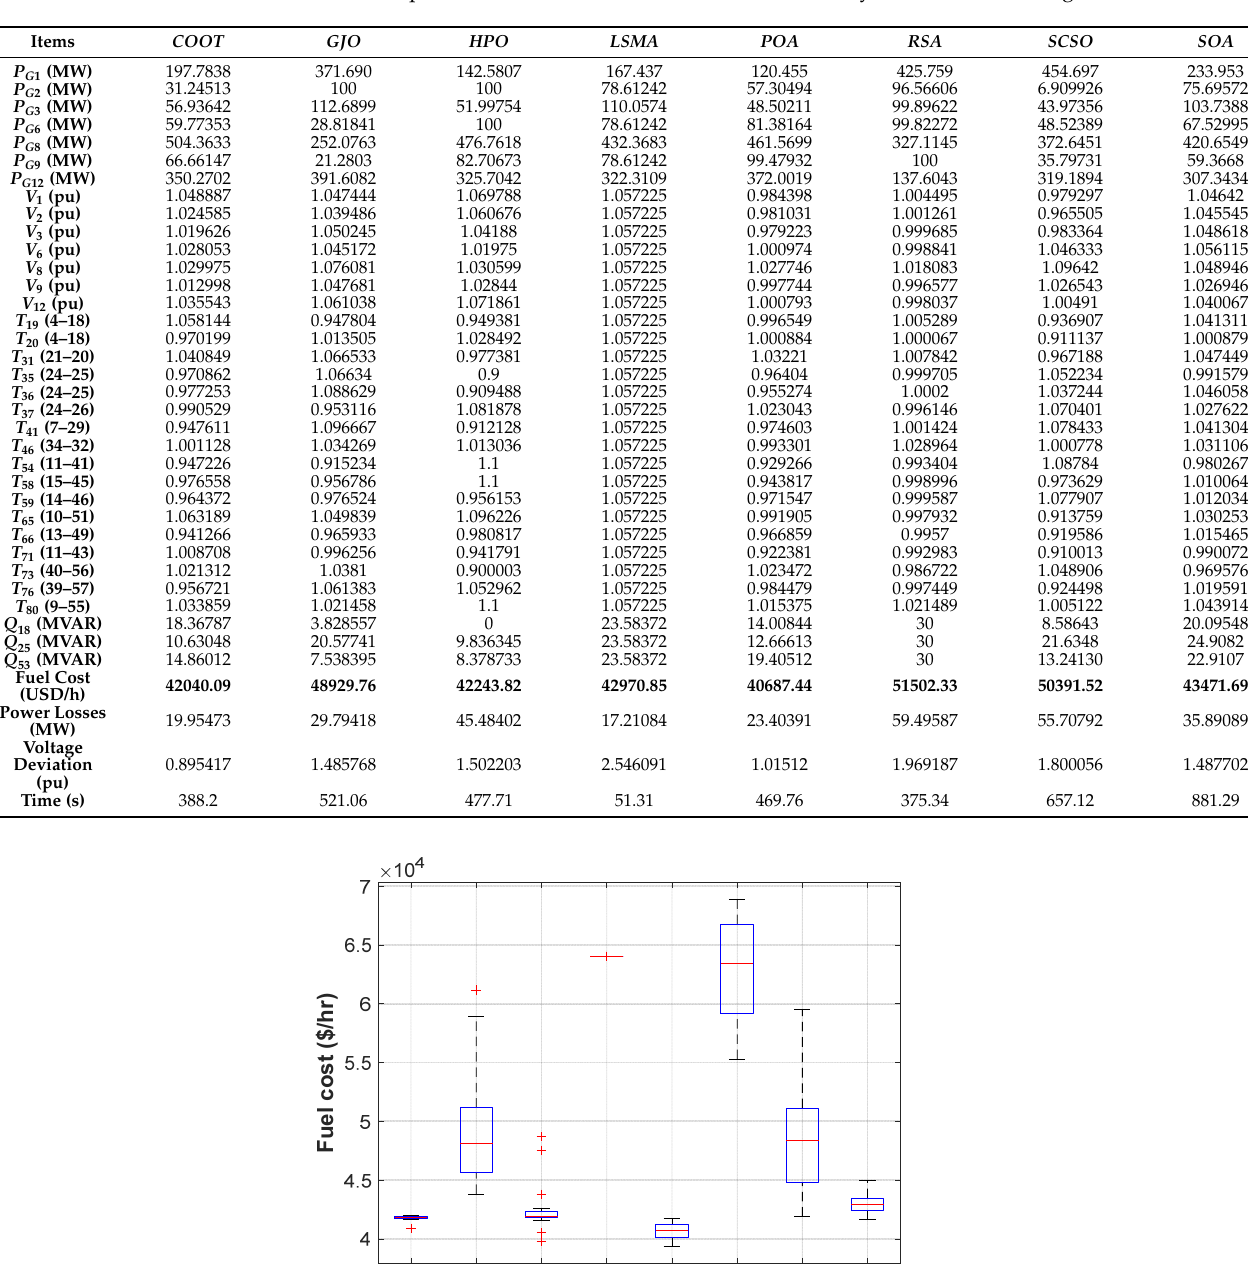
Table 7. Optimal control variables for IEEE 57-bus test system for minimizing fuel cost.